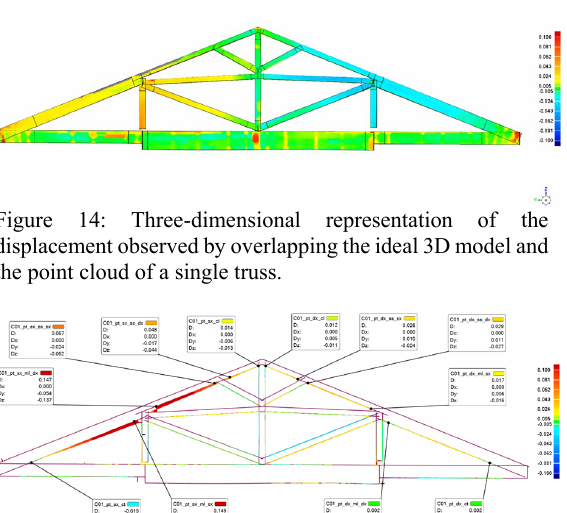
truss plane, displacements outside the truss plane of rafters and